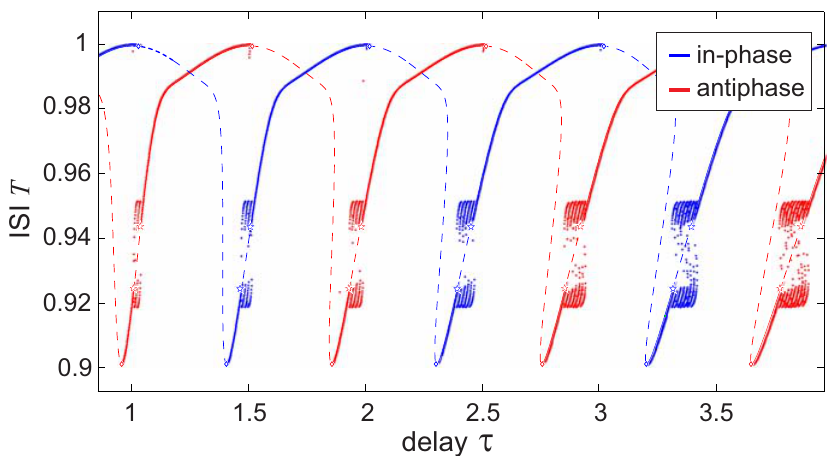
Fig. 3 The bifurcation diagram of two oscillators with mutual delayed coupling. The observed ISIs of the established dynamical regimes are plotted versus the time delay. Blue lines stand for near-in-phase, red for near-antiphase regimes. Theoretically predicted regular regimes are plotted by thin lines, solid for stable and dashed for unstable regimes. Diamonds depict saddle-node or period-doubling bifurcations, while stars depict multi-jitter bifurcations. Thick dots depict the numerical results. Note that almost everywhere the stable branches predicted by the theory are covered by numerically observed